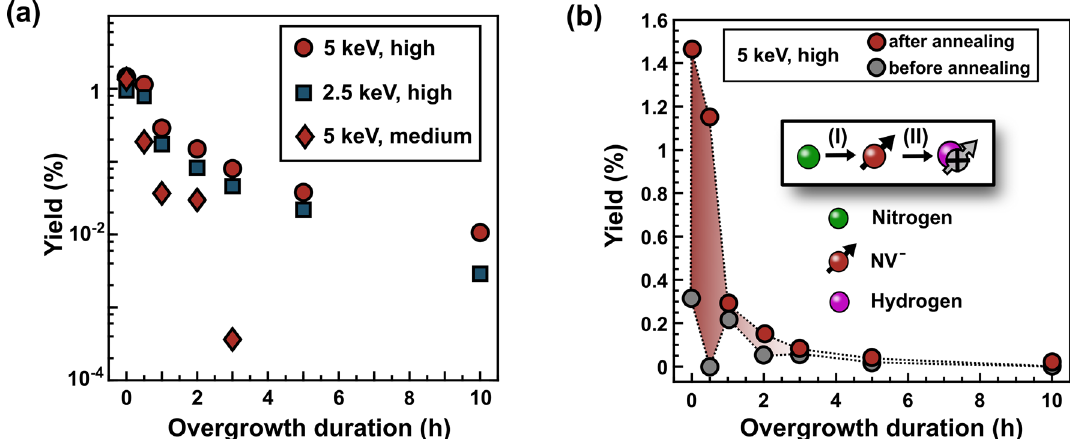
Figure 4. The loss of NV − centers caused by passivation during overgrowth. ( a ) The evolution of the yield over time in dependence of the implantation dose and energy. The yield is estimated by analyzing the NV − fluorescence profiles and comparing them with the one of a single NV − center. For details refer to C. Osterkamp et al. 40 . ( b ) Comparison of the yield directly after overgrowth with the one after annealing. The red shaded area is a measure for the nitrogen not converted into NV − centers during the CVD process. The schematic proposes a two-step mechanism for the passivation consisting of the formation of NV − centers (I) before hydrogen from the plasma can passivate them